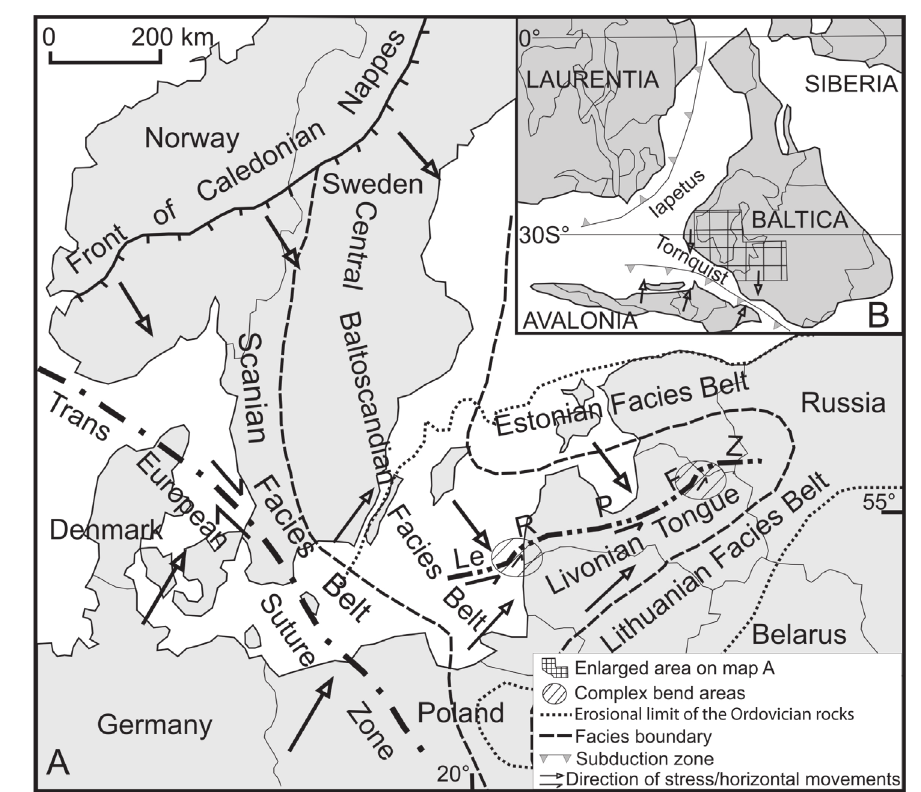
Fig. 2. A , general facies zonation indicating also the Livonian Tongue in the Ordovician Baltic Basin (modified after Kaljo et al. 2007); B , Late Ordovician (Katian, ~450 Ma) plate tectonic relations of the Baltica–Avalonia–Laurentia continents (modified after Torsvik & Cocks 2013) and suggested directions of palaeostresses with horizontal fault